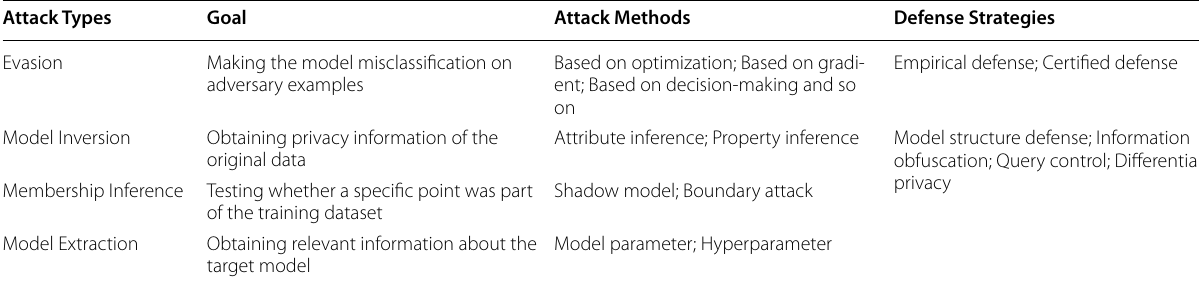
Table 4 Evasion and privacy inference attacks in the model predicting